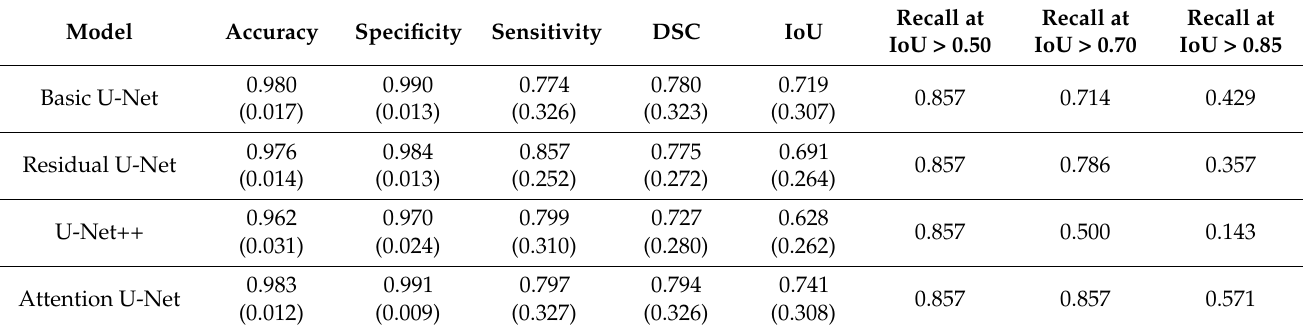
Table 2. Performance comparison of the deep-learning models for pancreatic cyst lesion segmentation on the internal test. The mean of performance is shown with the standard deviation in parentheses on the accuracy, specificity, sensitivity, dice similarity coefficient, and intersection over union. A recall score greater than the threshold is shown.